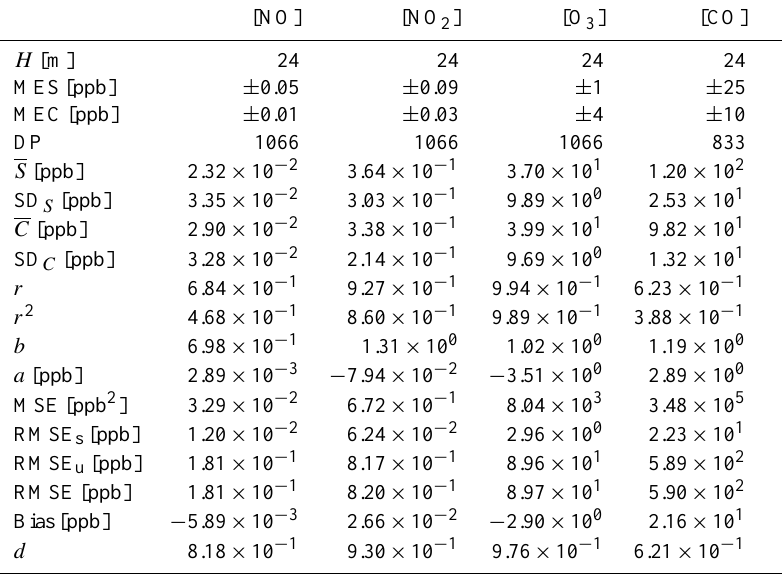
Table 1. Measurement uncertainty and estimates for quality of fit for the measured input gas concentrations. H is height, MES and MEC the estimated total accuracies calculated as a combination of precision and the accuracy of reading for the SMEAR II (MES) and campaign (MEC) instrumentation. DP is the number of measured data points considered, S and C the SMEAR II-measured ( S ) and campaign-measured ( C ) means, SD S and SD C the corresponding SD, r Pearson’s product-moment correlation coefficient which describes colinearity between measured and modelled parameters, r 2 the coefficient of determination which describes the proportion of the total variance explained by the model, b the slope, a the intercept of linear least-square regression. MSE is the mean square error, RMSE s systematic RMSE, RMSE u unsystematic RMSE, RMSE total root mean square error, bias the difference between C and S and d the index of agreement.